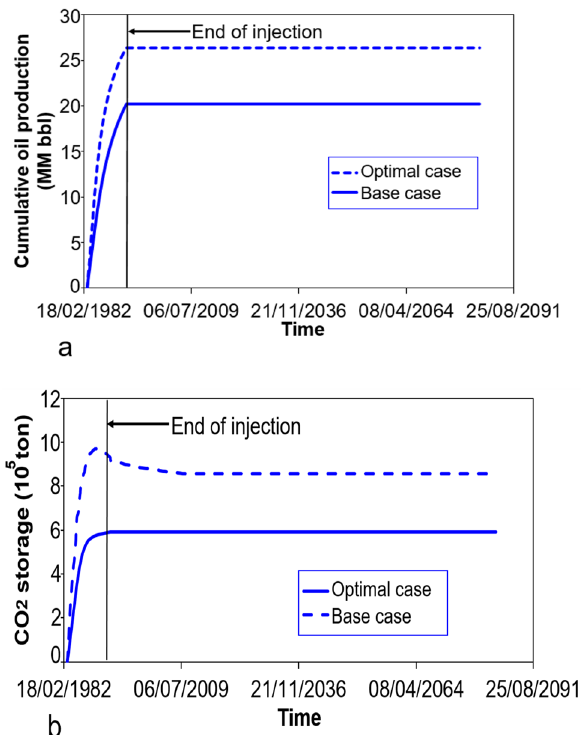
Figure 10. The cumulative oil production for the base case and optimal case ( a ); the CO 2 storage amount for the base case and optimal case ( b ).